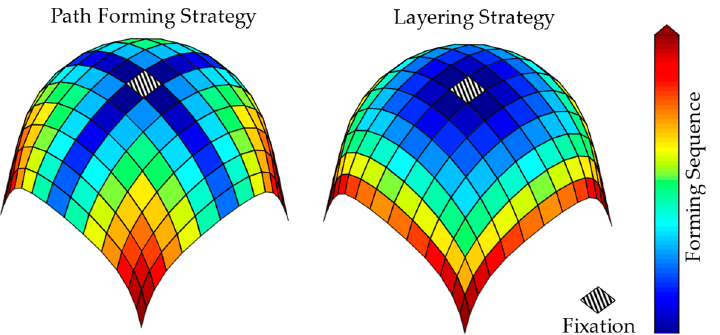
Figure 3. Draping strategies with sequence indication for dieless forming of a hemisphere, visualized on a distorted grid of pin-jointed cells, resulting from a kinematic draping simulation.